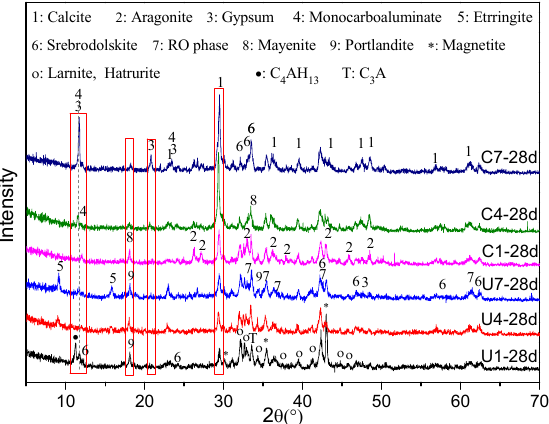
Figure 6. XRD patterns of the samples after 28 d of curing.